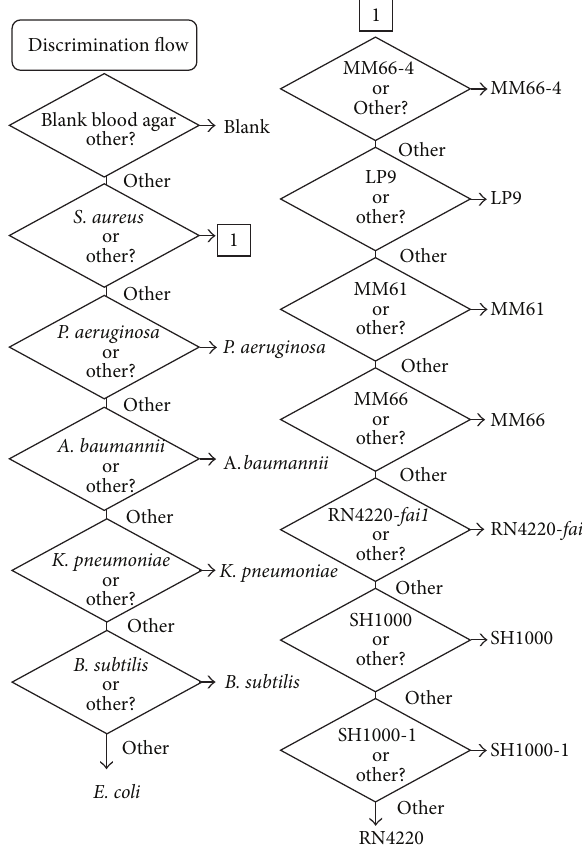
Figure 4: Complete discrimination flow for the discrimination of pathogens on blood agar isolation